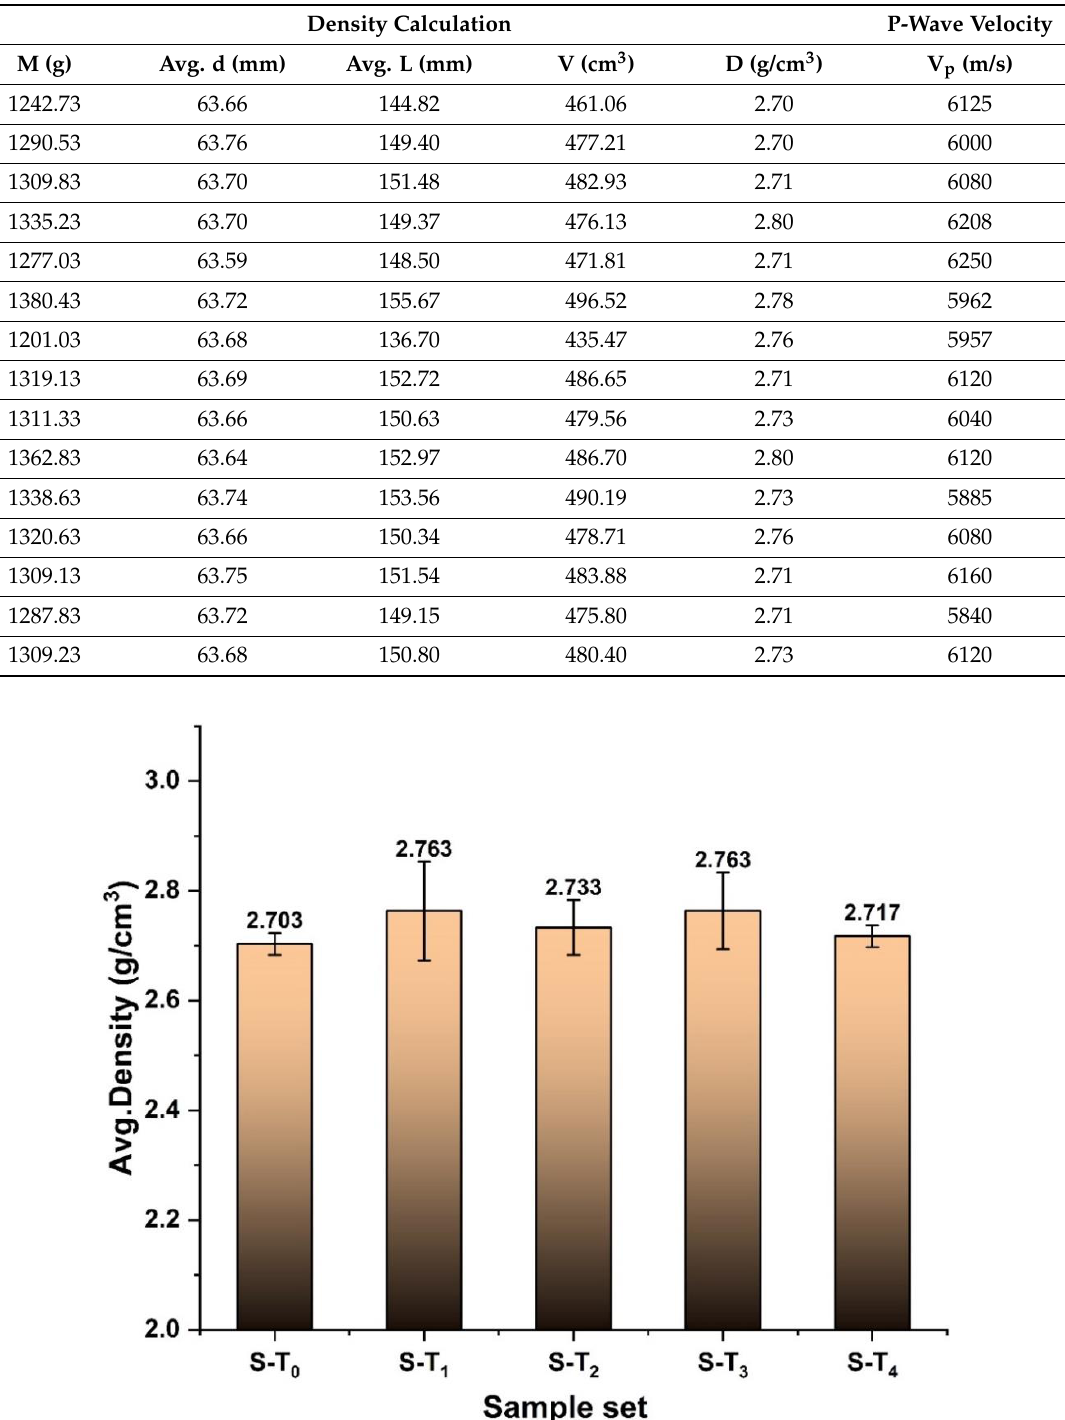
Table 3. The specimens’ density and P-wave velocity (Vp) at room temperature (22 ◦ C).